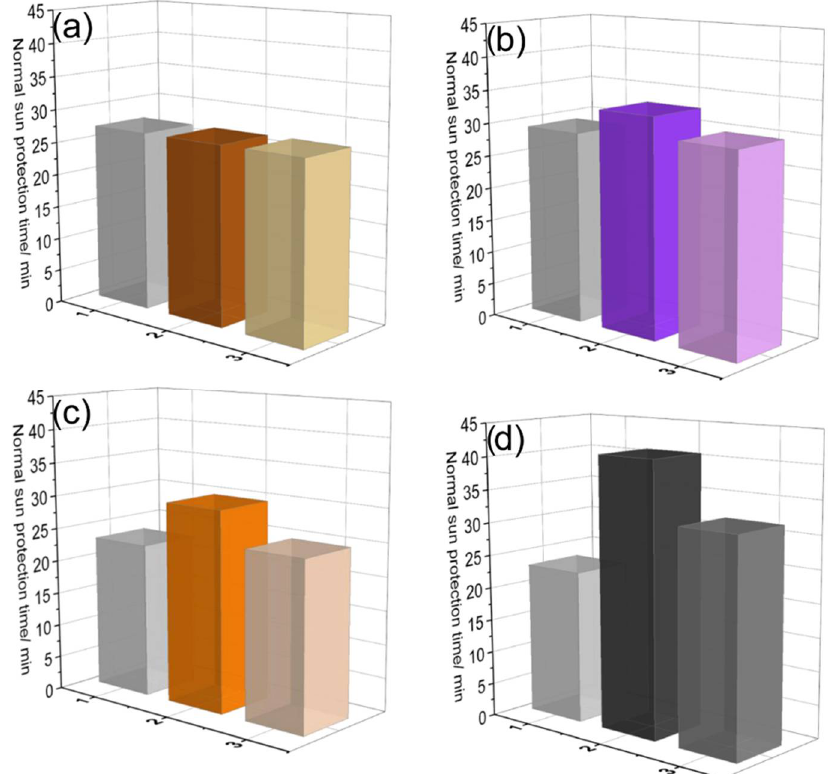
Figure 9. Graphs of natural sun protection time for skin: (1) before applying the cosmetic, (2) 20 min after cosmetic application, (3) after bath, for W/O emulsion ( a ) control, or with ( b ) TiO 2 , ( c ) TiO 2 /SiO 2 , and ( d ) TiO 2 /Ag. Values of normal sun protection time in minutes for test 1, 2, 3 are ( a ) 27; 27; 27, ( b ) 29; 33; 30, ( c ) 23; 30; 25, and ( d ) 23; 41; 32, respectively.